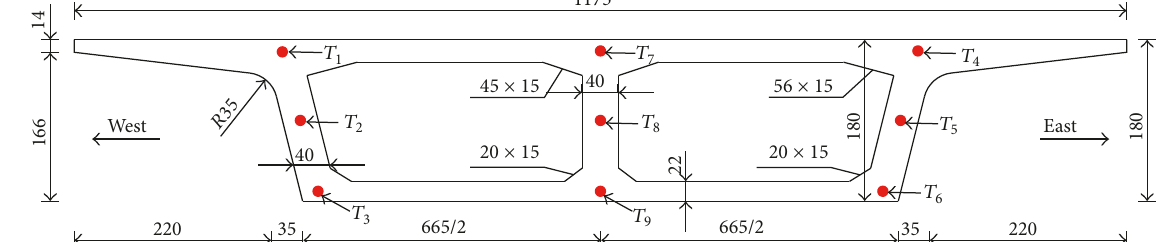
Figure 19: Cross-sectional dimension and layout of temperature sensors.